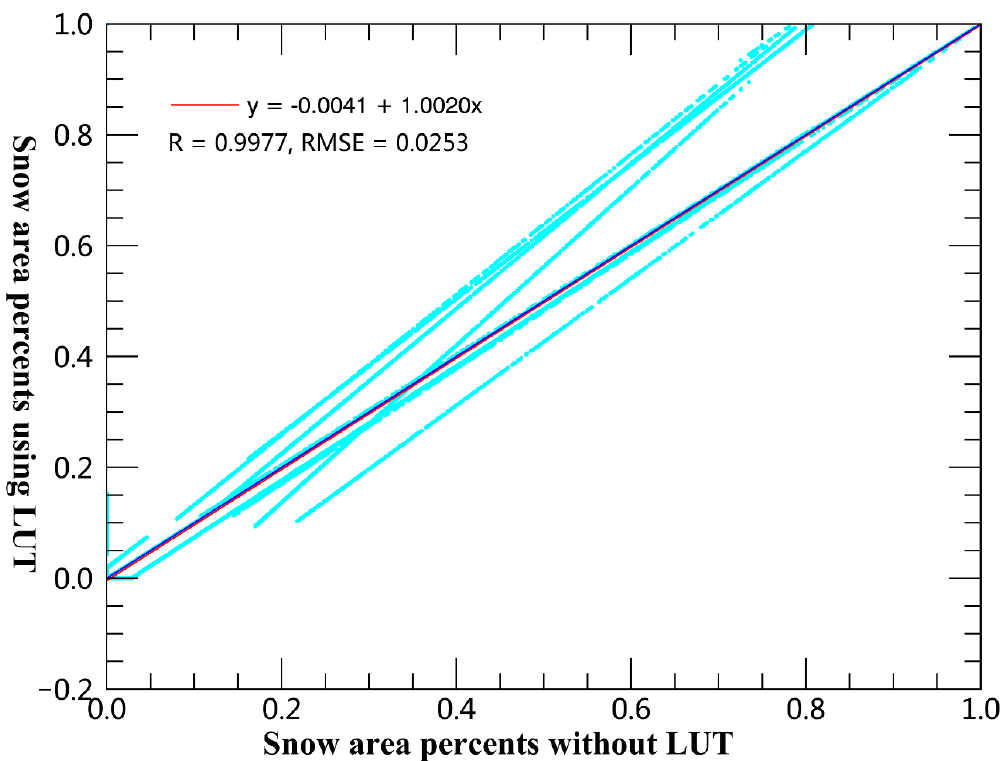
Figure 14. The comparison of the mapping results using LUT vs without using LUT (2).